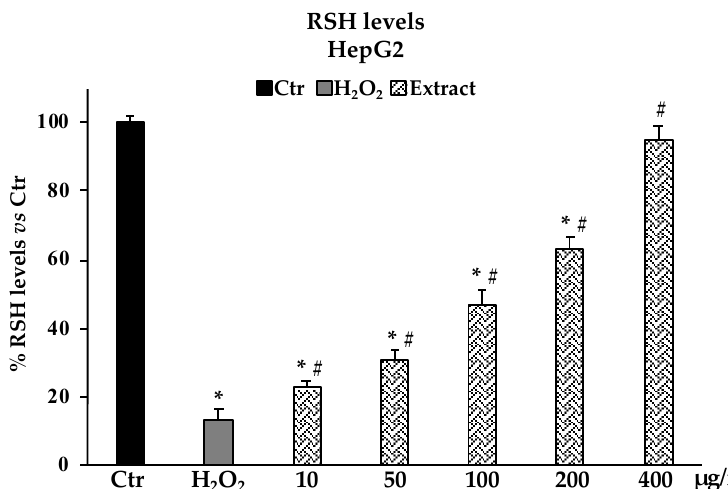
Figure 6. RSH (non-protein thiol groups) levels in HepG2 untreated cells (Ctr), treated for 2 h with H 2 O 2 200 μM (H 2 O 2 ), and pre-treated with Brassica raimondoi extract (10–50–100–200–400 μg/mL) and followed by H 2 O 2 treatment 200 μM 2 h. Values are the mean ± S.D. of five experiments in triplicate. Confidence intervals calculated by two-way ANOVA test: * Significant vs. untreated control cells: p < 0.001; # Significant vs. H 2 O 2 treated cells: p < 0.001. % RSH levels vs Ctr.: percentage of non-protein thiol groups vs. untreated control cells.